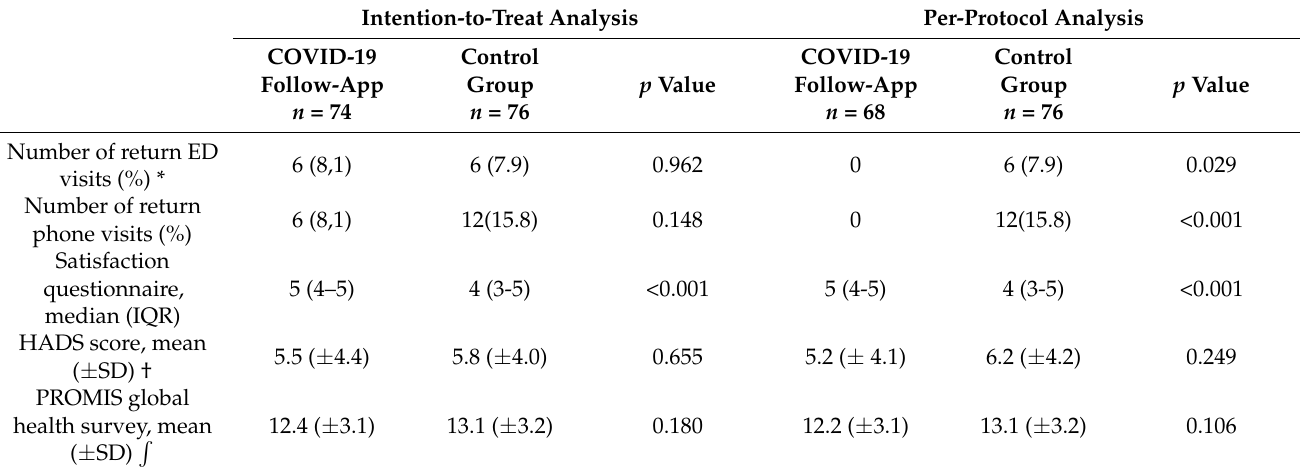
Table 3. Outcomes according to